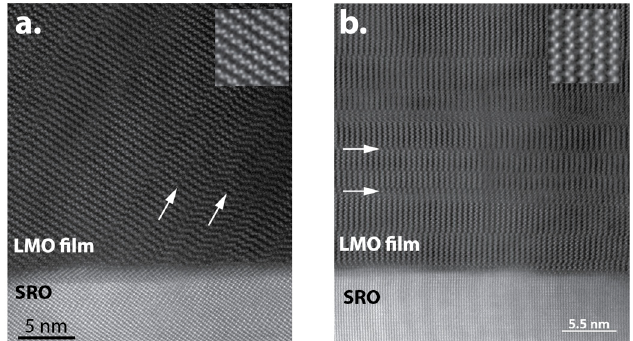
Figure 7. Cross-sectioned HAADF-STEM images of Li-Mn-O films grown at 800 °C on ( a ) SRO/STO(111) and ( b ) SRO/STO(100) substrates. The film was identified as having an o-LiMnO 2 structure. ( a ) Cross-section with STO in the [110] c zone axis shows a HAADF-STEM image of o-LiMnO 2 corresponding to the [001] o zone axis; ( b ) Cross-section with STO in the [110] c zone axis shows a HAADF-STEM image of o-LiMnO 2 corresponding to the [001] o zone axis (this is the same as in ( a ), but rotated 58.3° to match the (100) oxygen sublattice planes). Arrows show the presence of planar stacking faults parallel to (100) o . (Images are taken from our previously published work, see Ref. [15]).